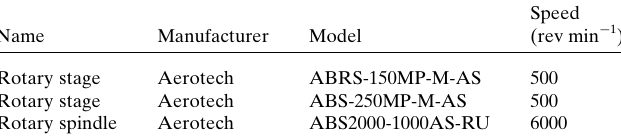
Table 4 Speed of rotary stage available at the Imaging Group of